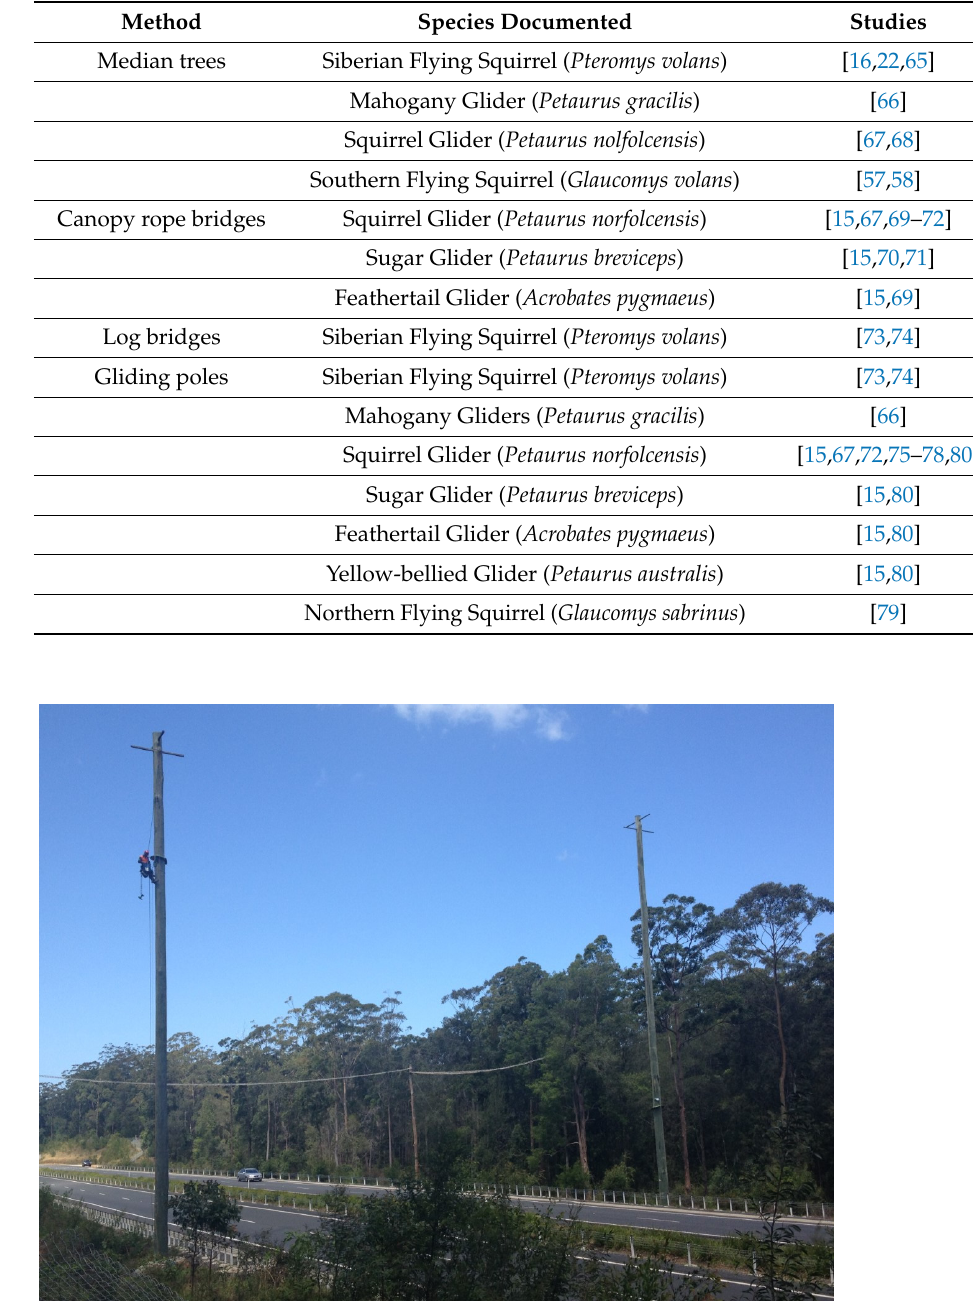
Table 1. Summary table of all crossing structures used by gliding mammals, which includes Ma- hogany Gliders, Squirrel Gliders, Sugar Gliders, Feathertail Gliders, Yellow-Bellied Gliders, Southern Flying Squirrels, Northern Flying Squirrels, and Siberian Flying Squirrels. Crossing structures are broken down into four categories: median trees, canopy rope bridges, log bridges, and gliding poles. All recorded species and their associated studies are included with the listed crossing structure.